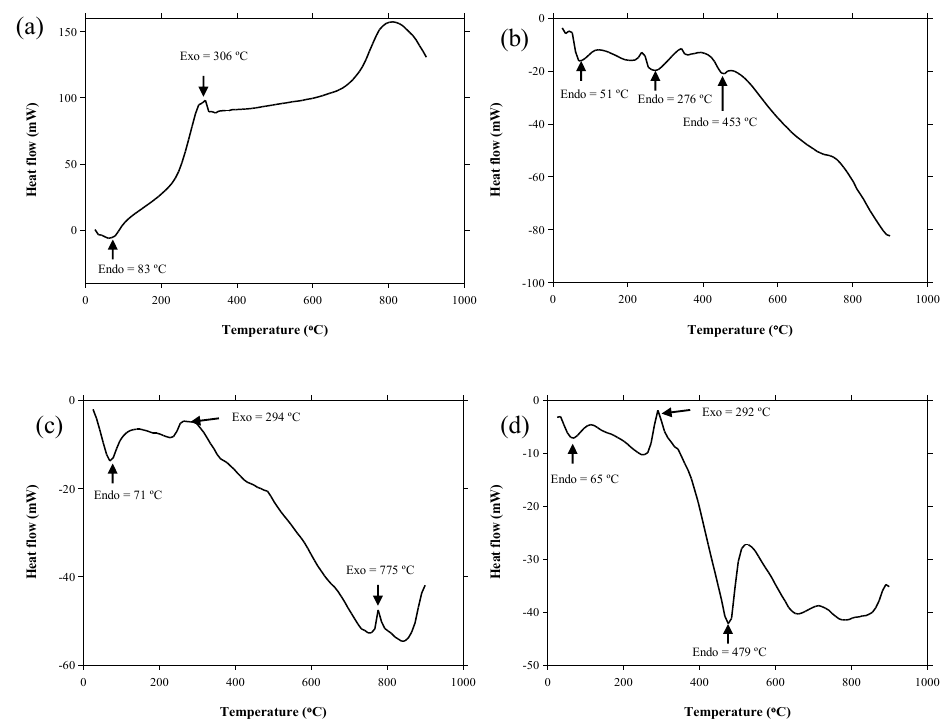
Figure 7: DSC thermograms of (a) chitosan, (b) NOOSC, (c) NONSC and (d) NOOGC.